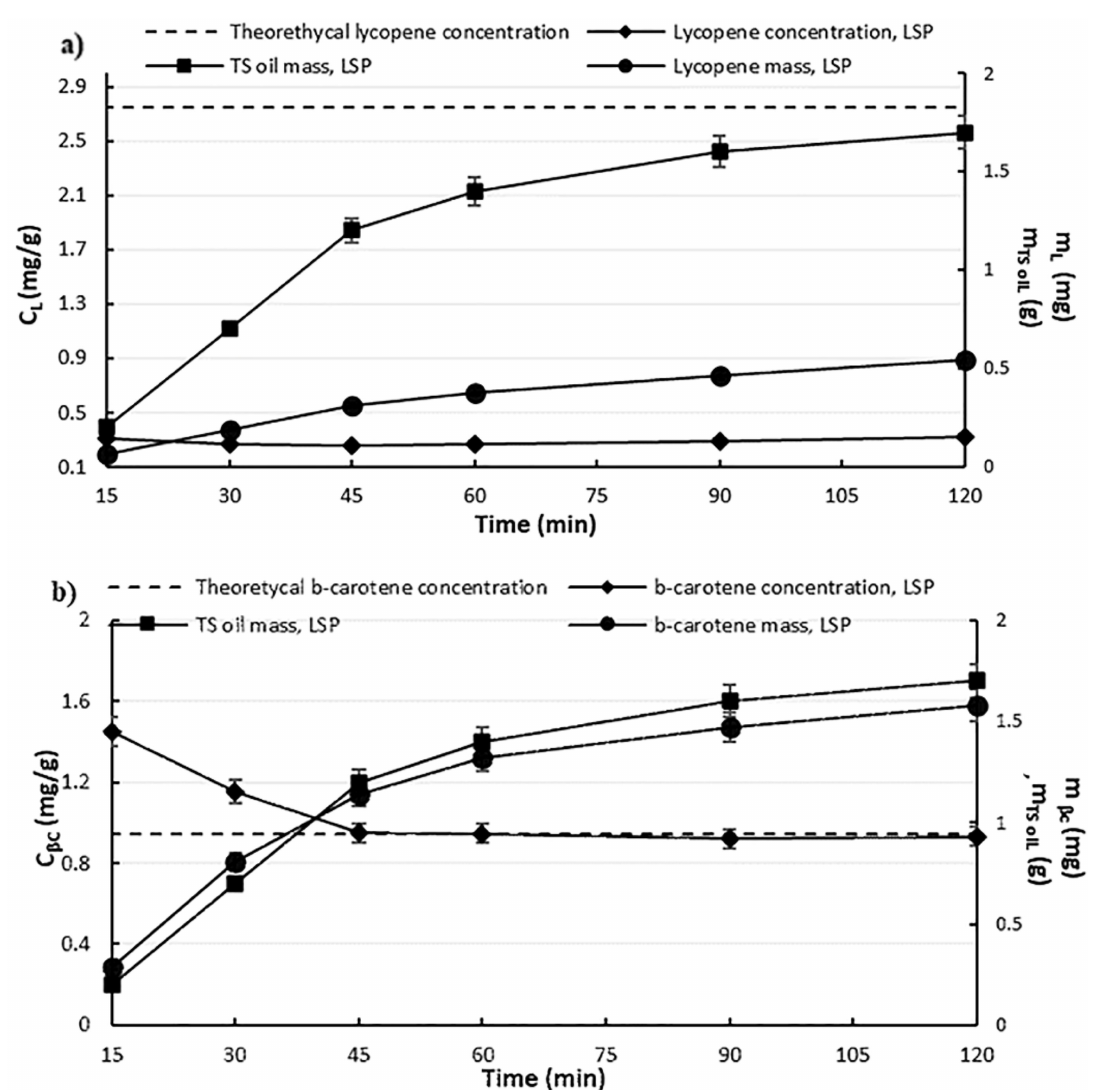
Figure 4. Lycopene ( a ) and β -carotene ( b ) concentrations in tomato seed oil (C L and C β c , respec- tively), tomato seed oil mass (m TS oil ), carotenoid mass (m L and m β c for lycopene and β -carotene, respectively) evaluated during trial #6 with layered arrangement (LSP). Theoretical concentrations of lycopene and β -carotene were indicated by horizontal dashed